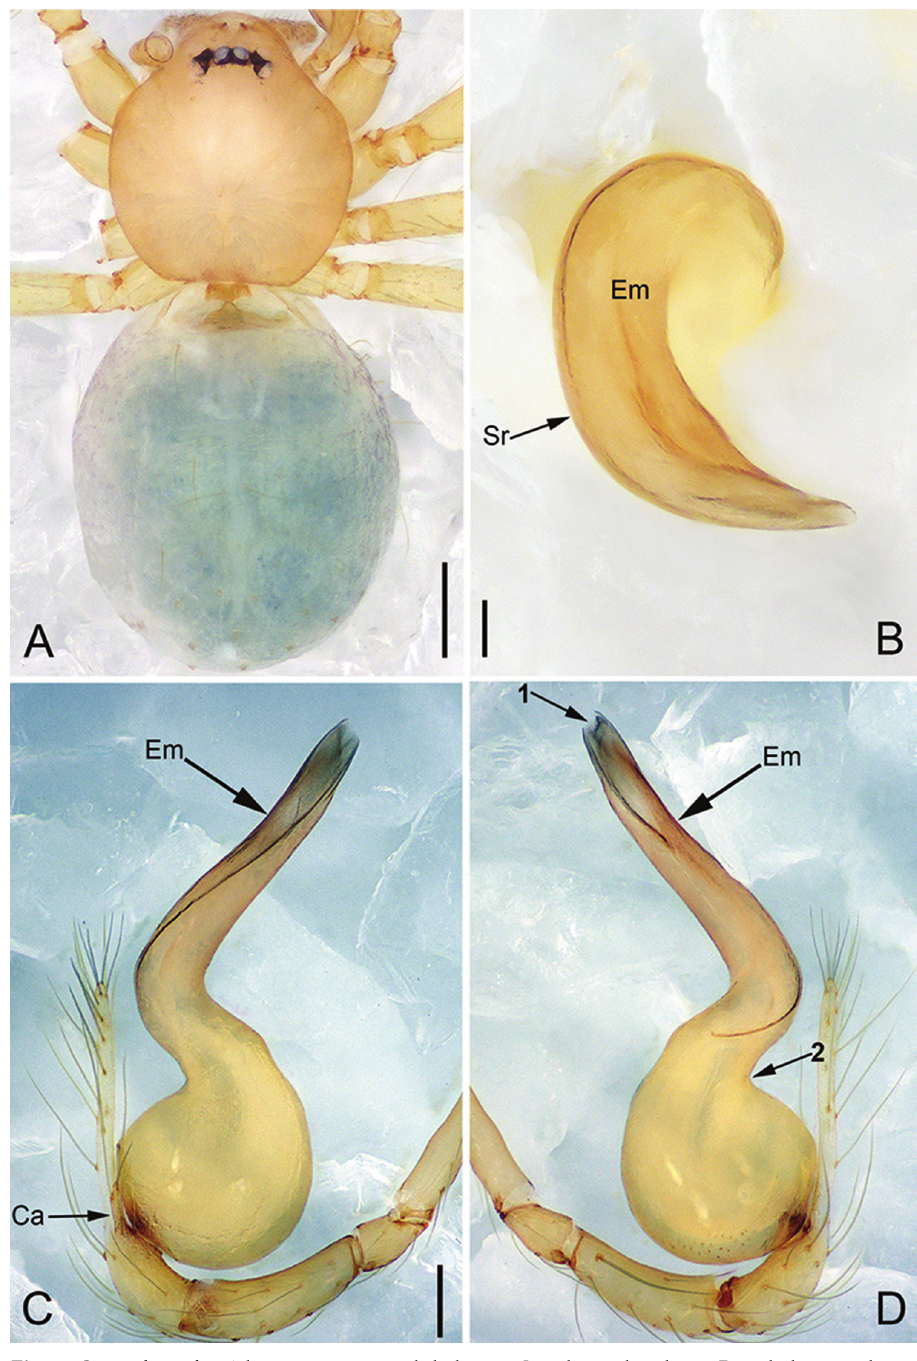
Figure 3. Pinelema cheni Zhao & Li, sp. n., male holotype. A Habitus, dorsal view B Embolus, apical view C Palp, prolateral view D Palp, retrolateral view. Scale bars: 0.2 mm ( A ), 0.05 mm ( B ), 0.1 mm ( C–D